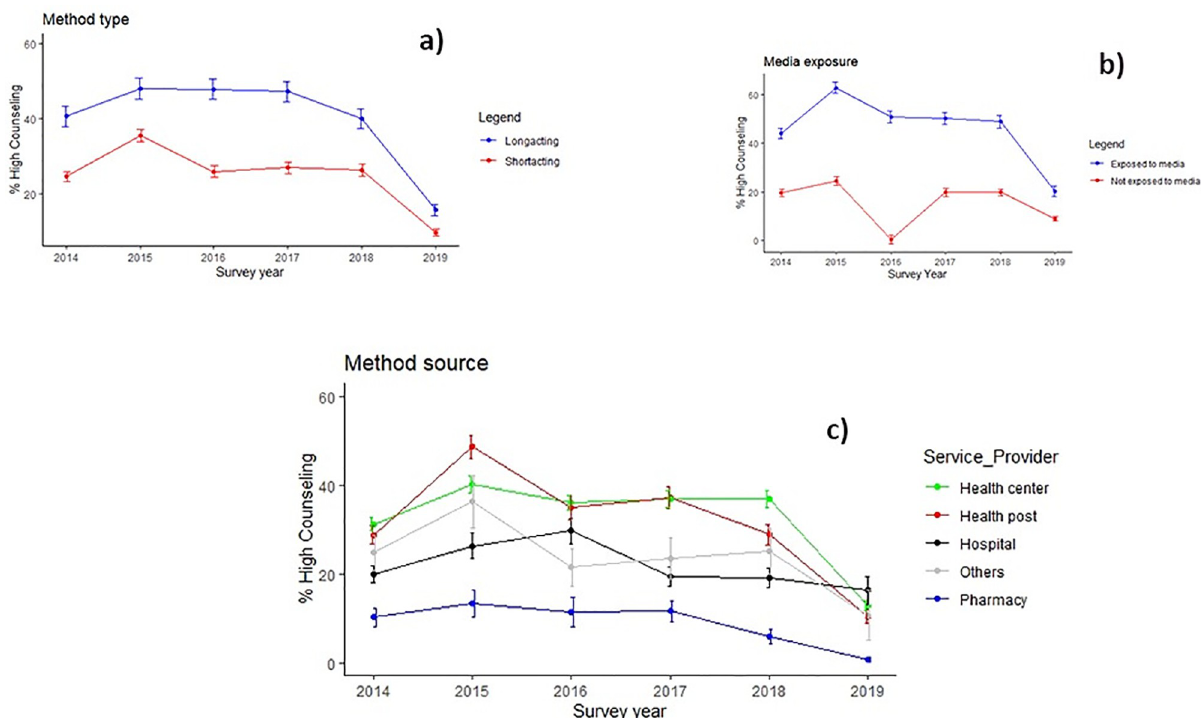
Fig 3. Trends in receipt of high quality family planning counseling by different factors. Percentage of women who received high family planning counseling service according to: a) type of method used, b) exposure to family Planning via media, and c) source of contraceptive method.